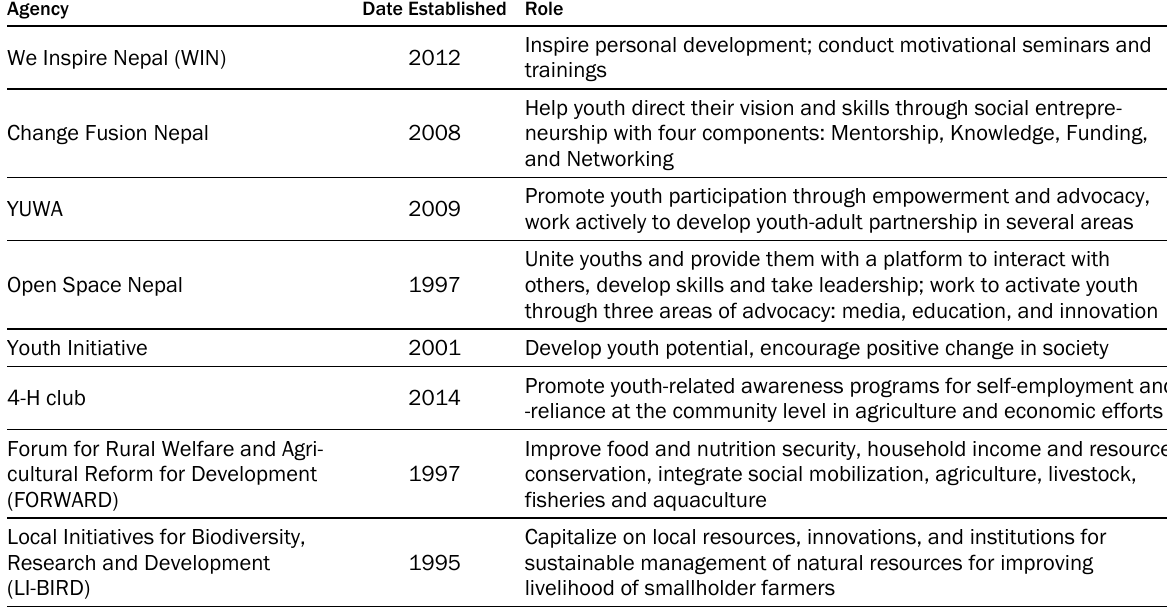
Table 3. Agencies Involved in Empowering Youth in the Study Area